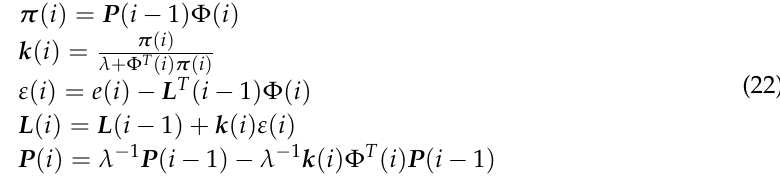
Table 1. Aeroelastic parameters representative of the wind tunnel test rig [22].